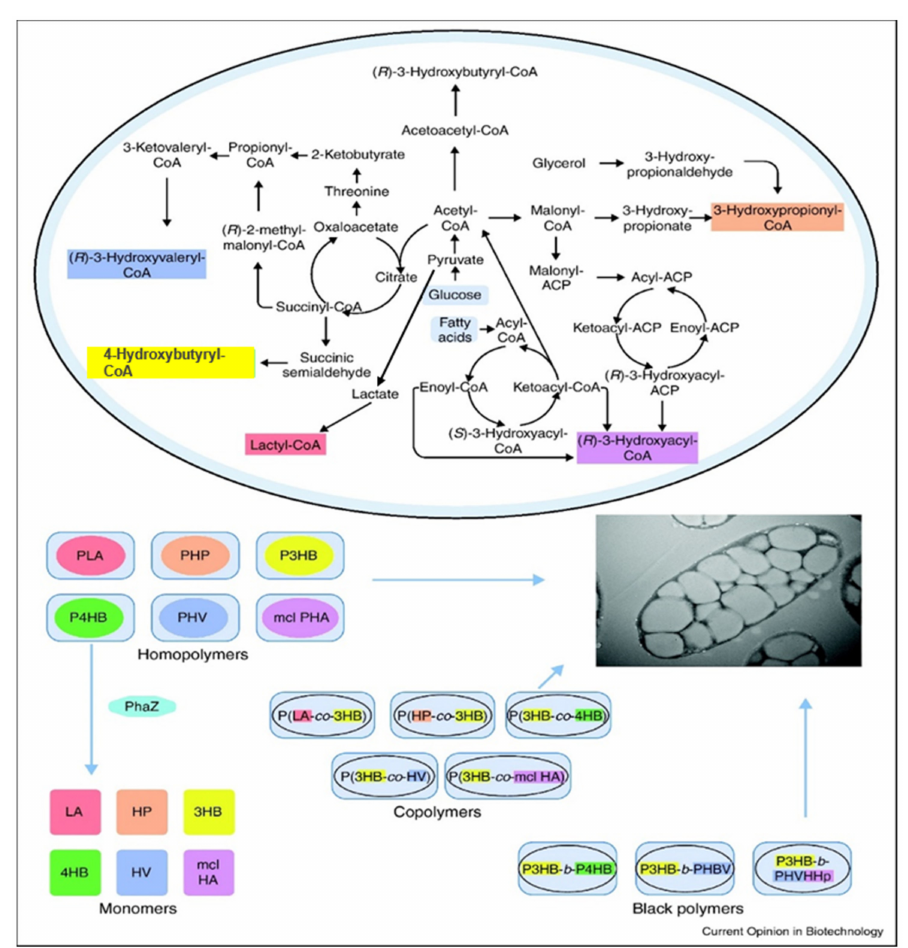
Figure 3. Microbial synthesis of PHAs. Key metabolic paths for the production of precursors for PHAs Reproduced with permission from [30]. Copyright 2011 Elsevier